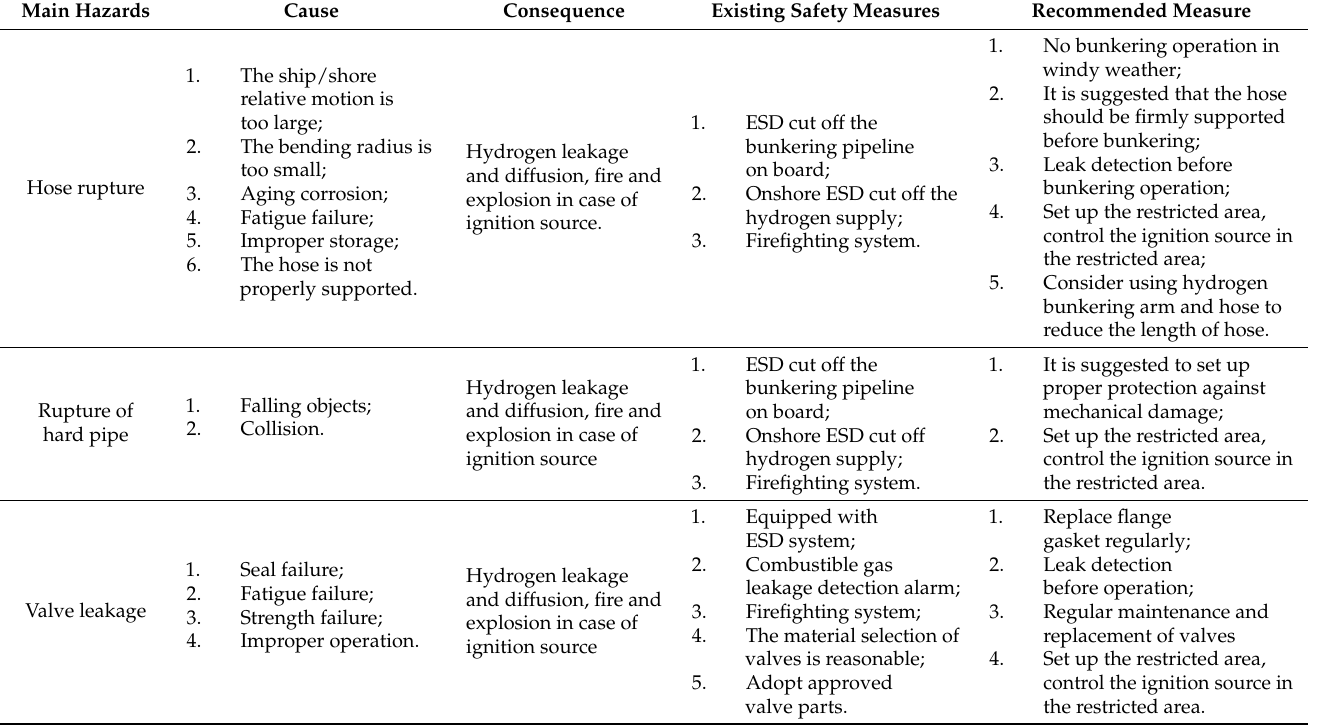
Table 2. Identification table of the main hazards for shore-based bunkering system for hydrogen powered ships.